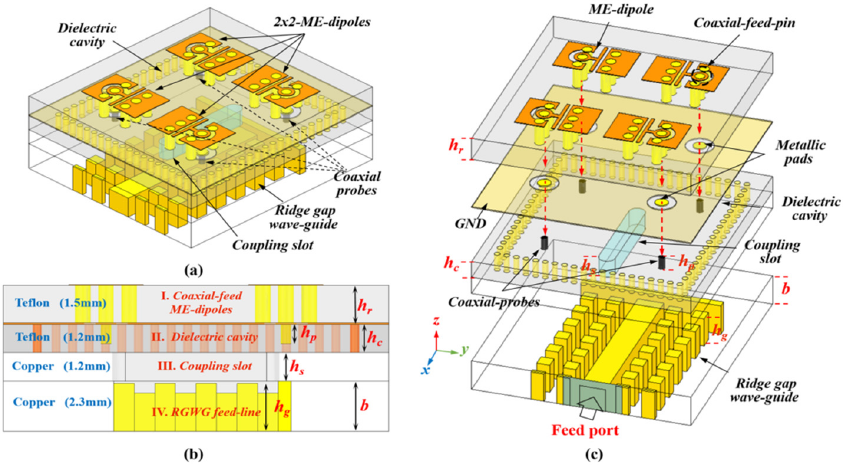
Figure 13. Hybrid feed geometry of a 2 × 2 unit for ME dipole subarray. ( a ) Perspective view. ( b ) Side view. ( c ) Exploded view [58]. view. ( c ) Exploded view